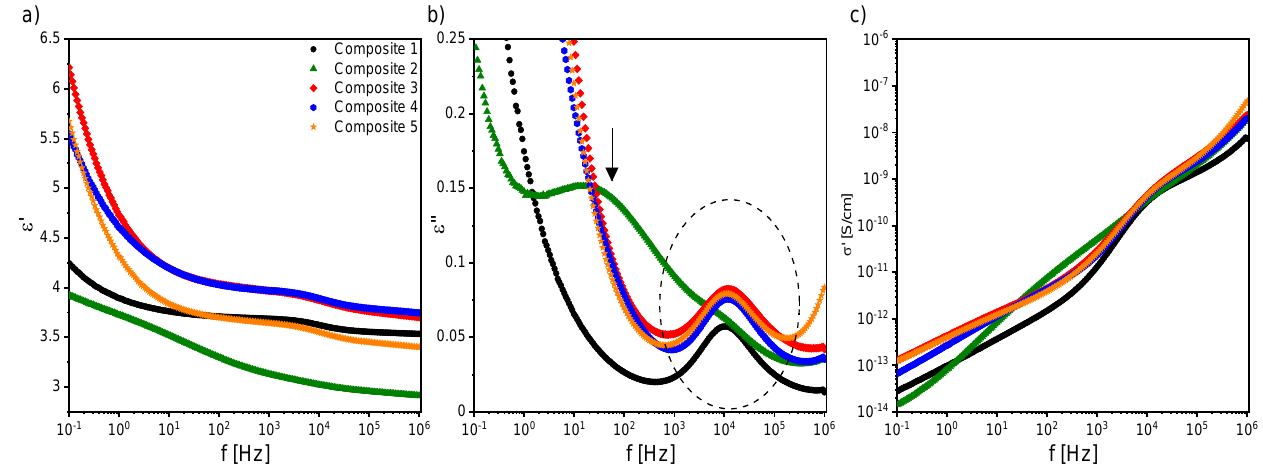
Figure 11. Dielectric dispersion ( a ) and absorption ( b ), as well as real component of the specific electric conductivity ( c ) for Composites 1 – 5 in the crystal phase (30 °C). The vertical arrow in ( b ) indicates the additional process registered for Composite 2. The legend in graph ( a ) is the same for all graphs. The dashed ellipse in ( b ) surrounds the high-frequency process present for all nanocomposites in the crystal phase.